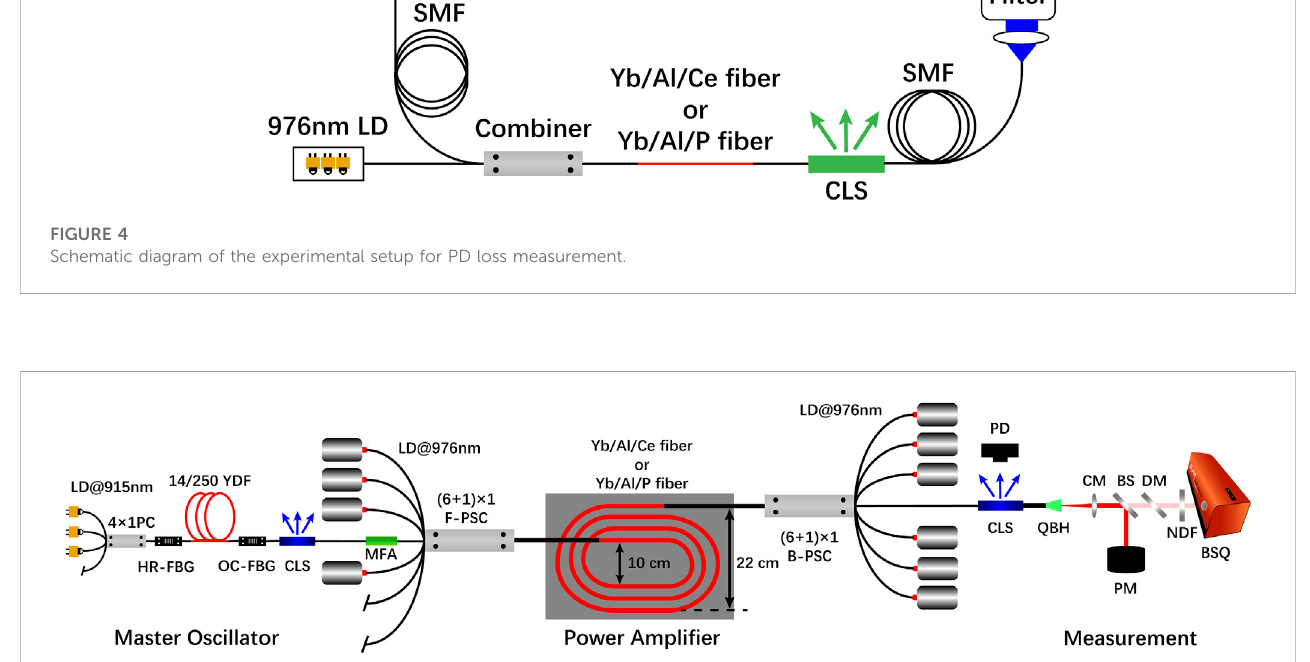
FIGURE 5 Schematic diagram of the experimental setup for laser performance measurement. LD, laser diode; PC, pump combiner; HR-FBG, high re fl ectivity fi ber Bragg grating; OC-FBG, output coupler fi ber Bragg grating; CLS, cladding light stripper; MFA, mode fi eld adaptor; F- and B-PSC, forward- and backward- pumpandsignalcombiner;PD,photodetector;QBH,quartzblockholder;CM,collimatingmirror;BS,beamsplitter;DM,dichroicmirror;NDF,neutraldensity fi lter; BSQ, beam